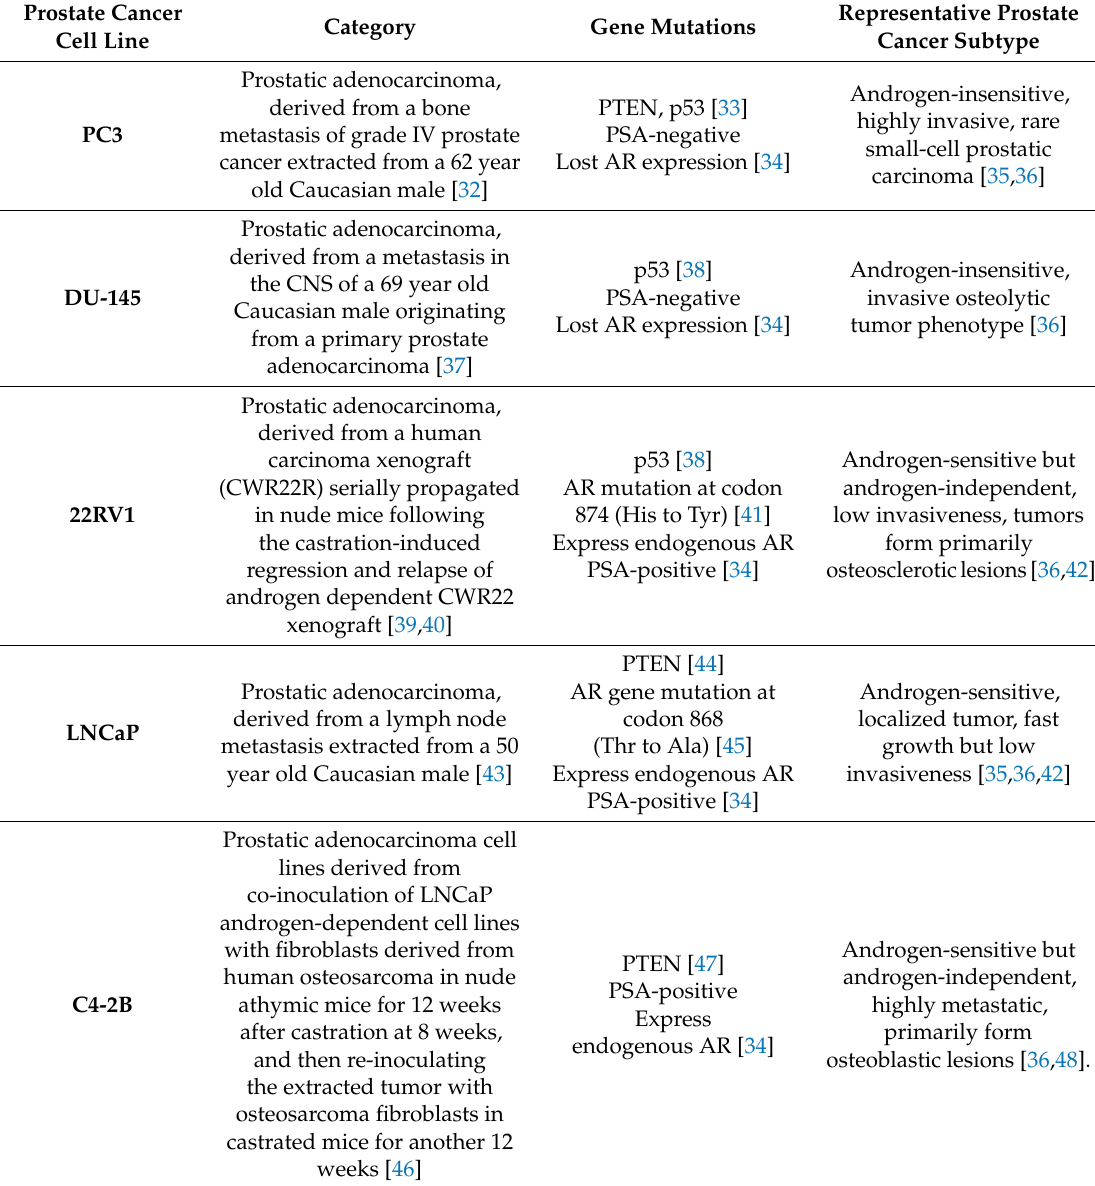
Table 2. Major prostate cancer cell lines and representative prostate cancer